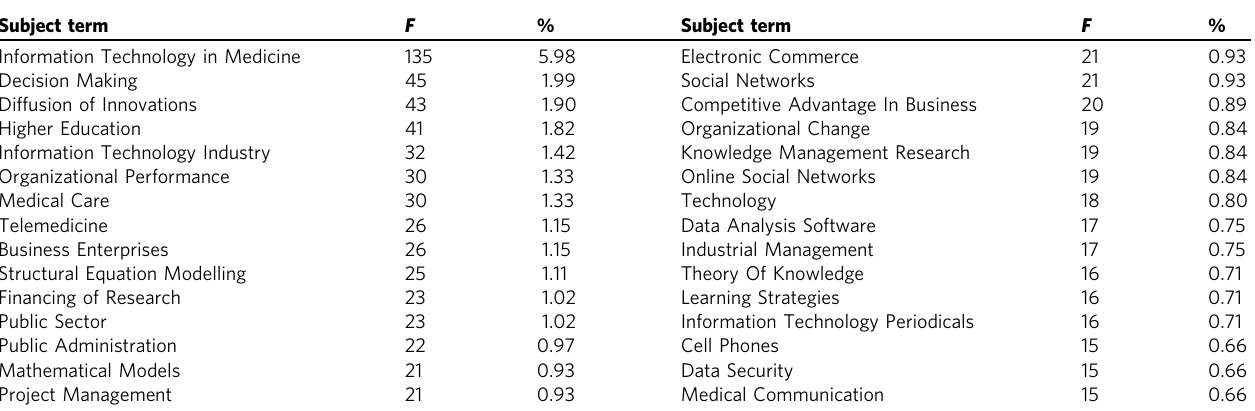
Table 5 Core subject terms in ICT research, 2013 –